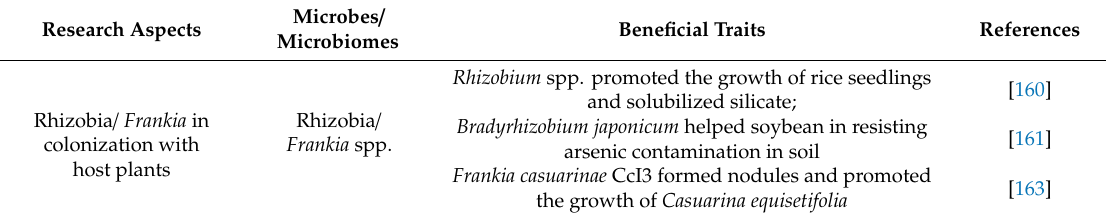
Table 1. Several representative applications of microbes in crop plants. ACC,